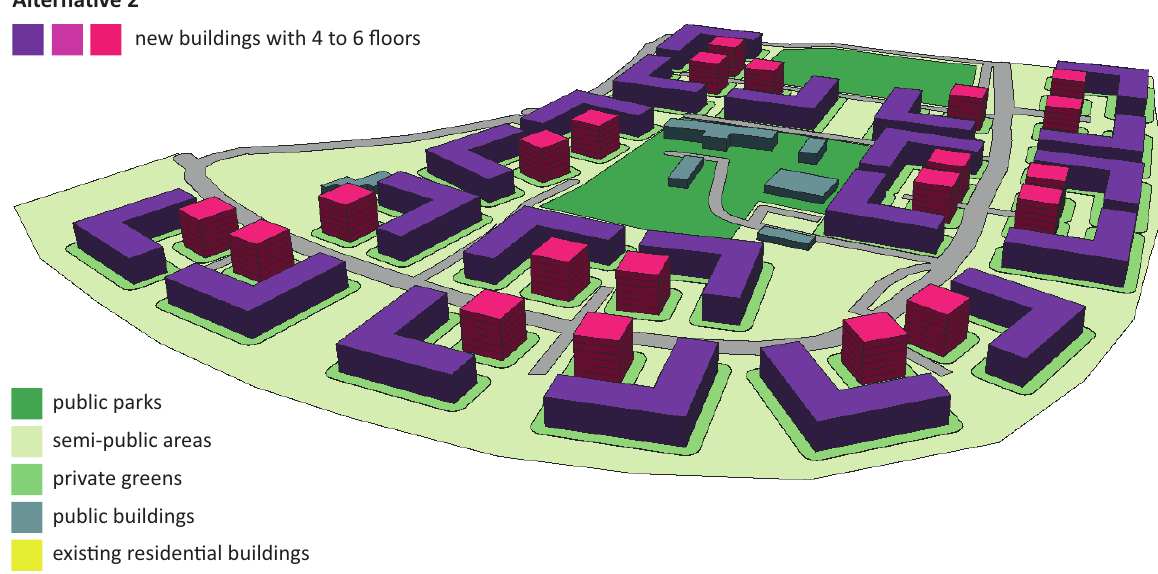
Figure 4. Alternative 2: “Community alternative,” promoting social and community performance.